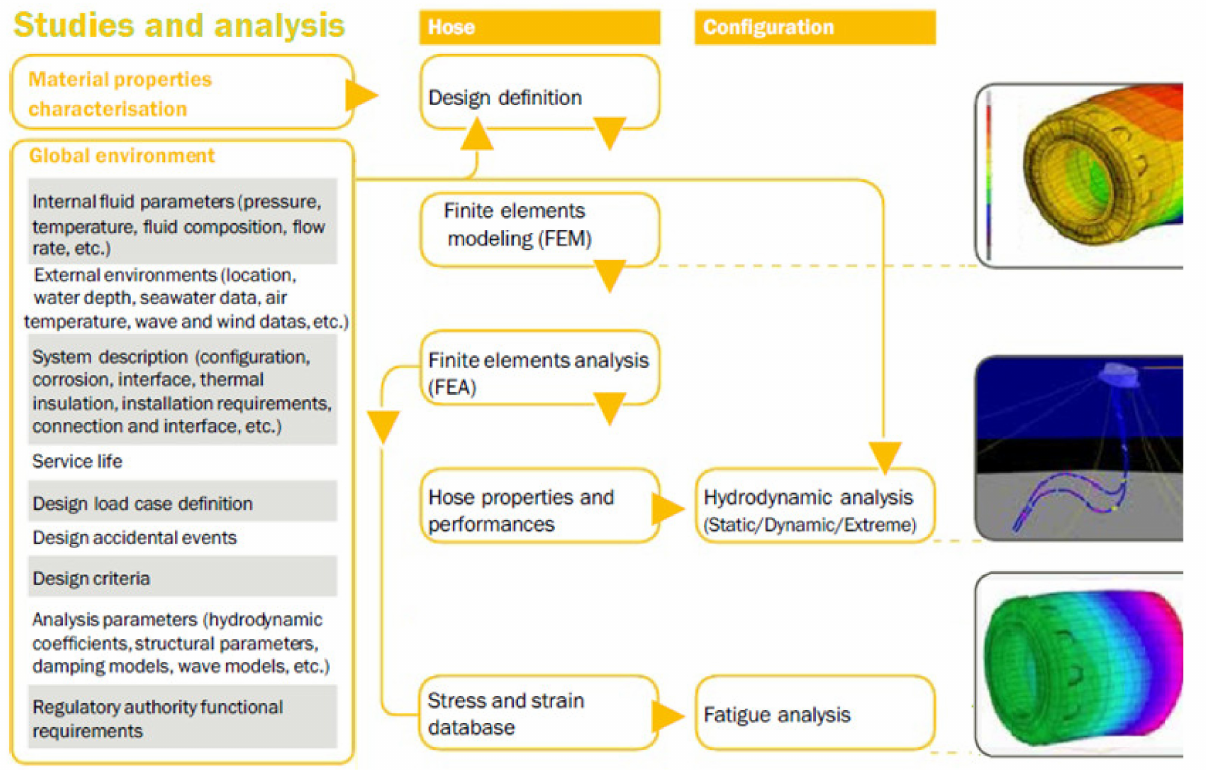
Figure 15. Typical design flowchart of a marine hose structure (Courtesy: